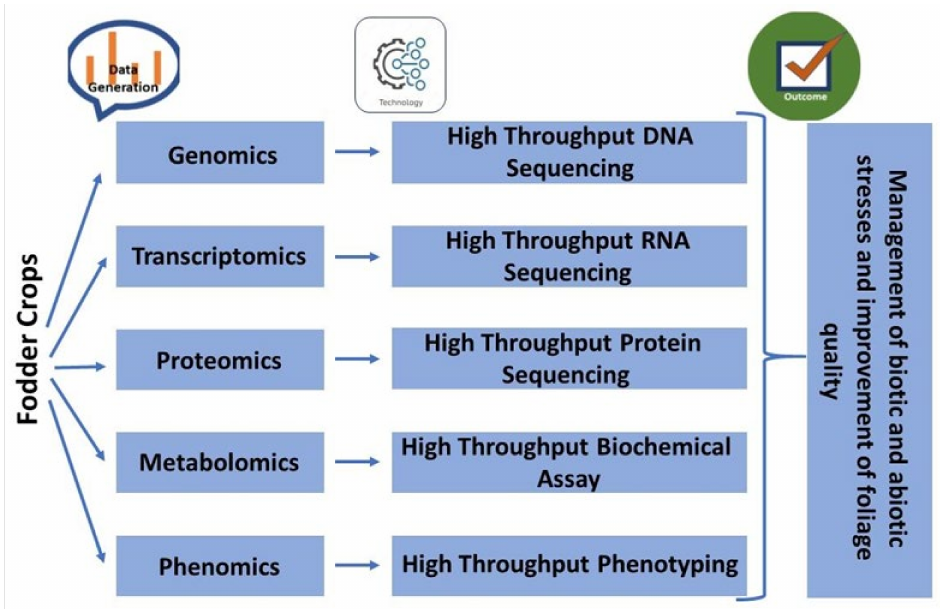
Figure 1. Multiple omics approach for fodder quality improvement in crop